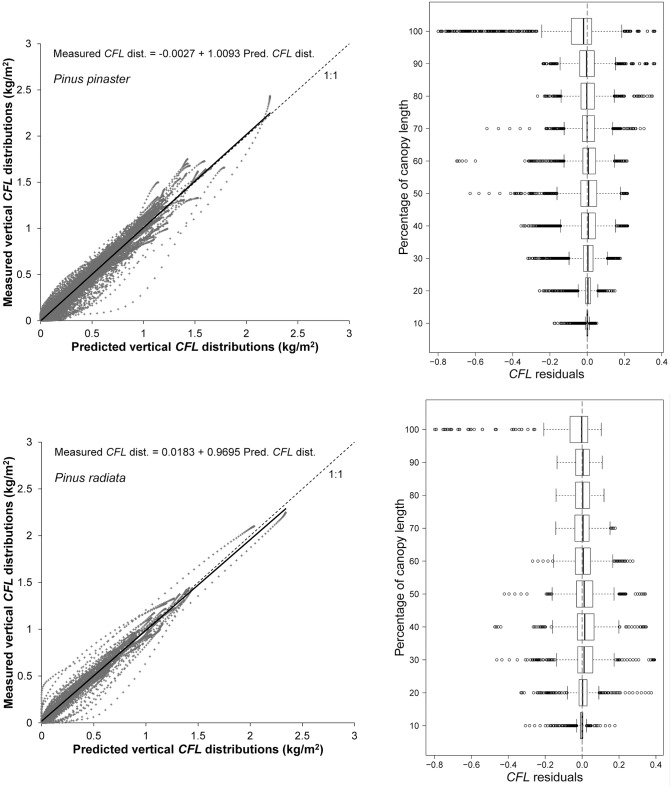
Scatter diagrams of vertical CFL distributions estimated from field data against predicted vertical CFL distributions obtained using stand variables as predictors.The solid line represents the linear model fitted, and the broken line is the 1:1 line (left, first column). Box plot of CFL residuals (using stand variables as predictors) against canopy length classes (right, second column). Graphs for P. pinaster are in the first row and for P. radiata in the second row.